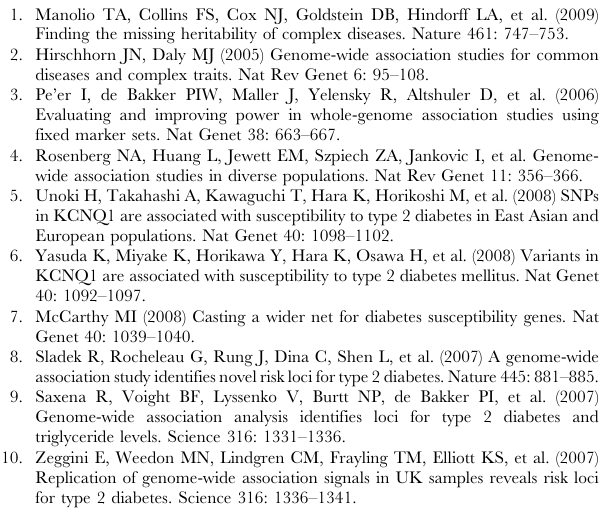
panels as well as multiethnic GWAS, in which samples for stage 2 of the GWAS are drawn from the major continental population panels or the major continental plus the admixture population panels. Data points referred to in the paper and in figures appear in bold. Table S4 Power to detect an association for a sample size of 10,000 using 1000 Genomes data. Population panels in the 1000 Genomes data are CEU, CHB + JPT, and YRI. Data points referred to in the paper and in figures appear in bold. Table S5 Power to detect an association for a sample size of 20,000 using 1000 Genomes data. Data points referred to in the paper and in figures appear in bold. Table S6 Power to detect an association for a sample size of 80,000 using 1000 Genomes data. Power for individual population panels as well as multiethnic GWAS is calculated for this sample size, as in the HapMap 3 analysis. Data points referred to in the paper and in figures appear in bold. Table S7 Sample size needed to replicate known GWAS findings in samples from HapMap 3 population panels. The sample size needed to replicate a GWAS finding at $ 80% power is reported for each of the 11 HapMap 3 population panels. Sample sizes listed as ‘‘NA’’ are annotated as such because the particular SNP is monomorphic in that population panel. SNPs that do not reach 80% power for 150,000 samples are footnoted and power at 150,000 samples is